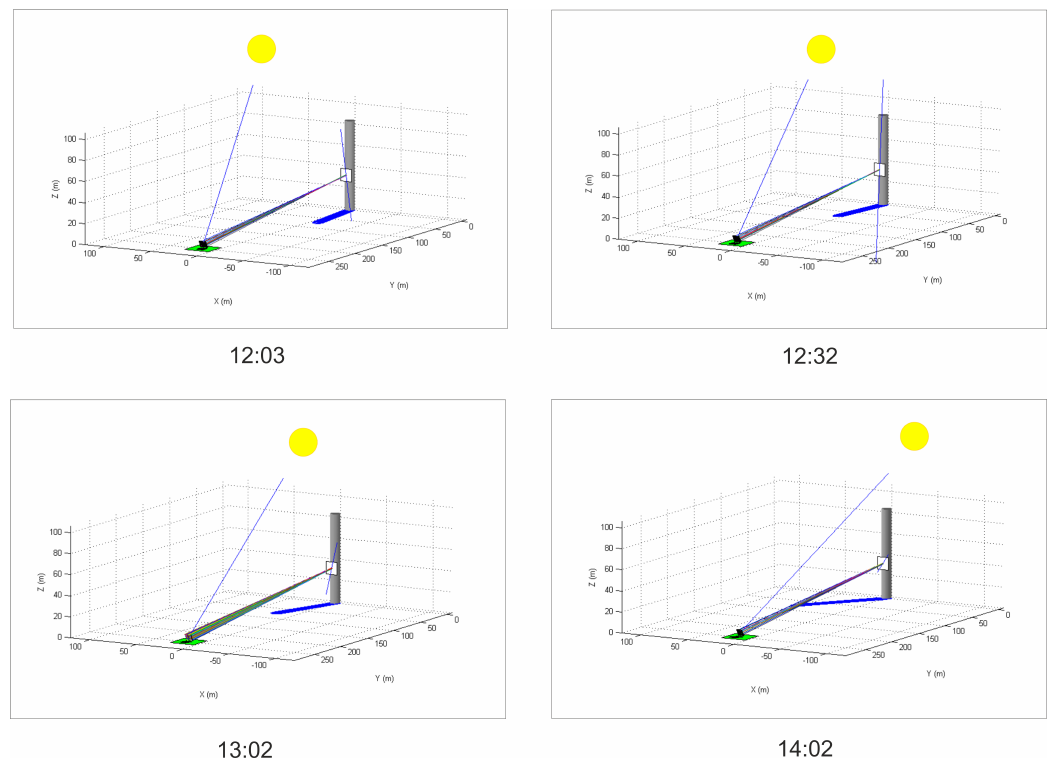
Figure 11. Scheme of the DNI forecasting simulation on the target (10 March 2017 at 12:02